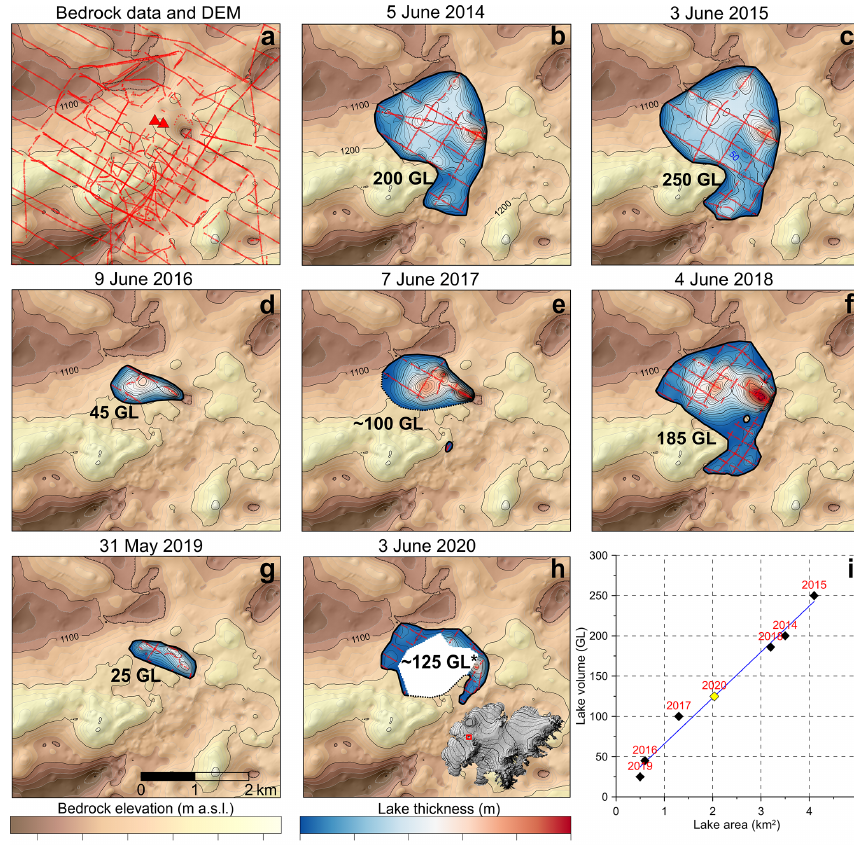
Figure 6. (a) The location of traced reflections classified as reflections from bedrock (red lines) in the combined 2014–2020 RES record along with elevation of bedrock measured through boreholes (red triangles) used to interpolate a DEM of the bedrock beneath the ESC and near vicinity (area shown with red box in inset image on h ). This DEM, represented with the elevation contour map (20m contour interval), is shown in the background of (a) – (h) . (b–h) Maps of lake thickness along with the location of traced reflections classified as reflections from the lake roof (red lines), used to interpolate the lake thickness map for each survey. Lake volumes integrated from the lake thickness maps are displayed in GL (10 6 m 3 ). (i) The lake volume posted as a function of lake area (in 2014–2019; black diamonds), which constrains a linear relation (blue line) used to estimate the lake volume in 2020 (value marked with ∗ in panel h and yellow diamond in panel i ), when the lake thickness map had a large data gap (white